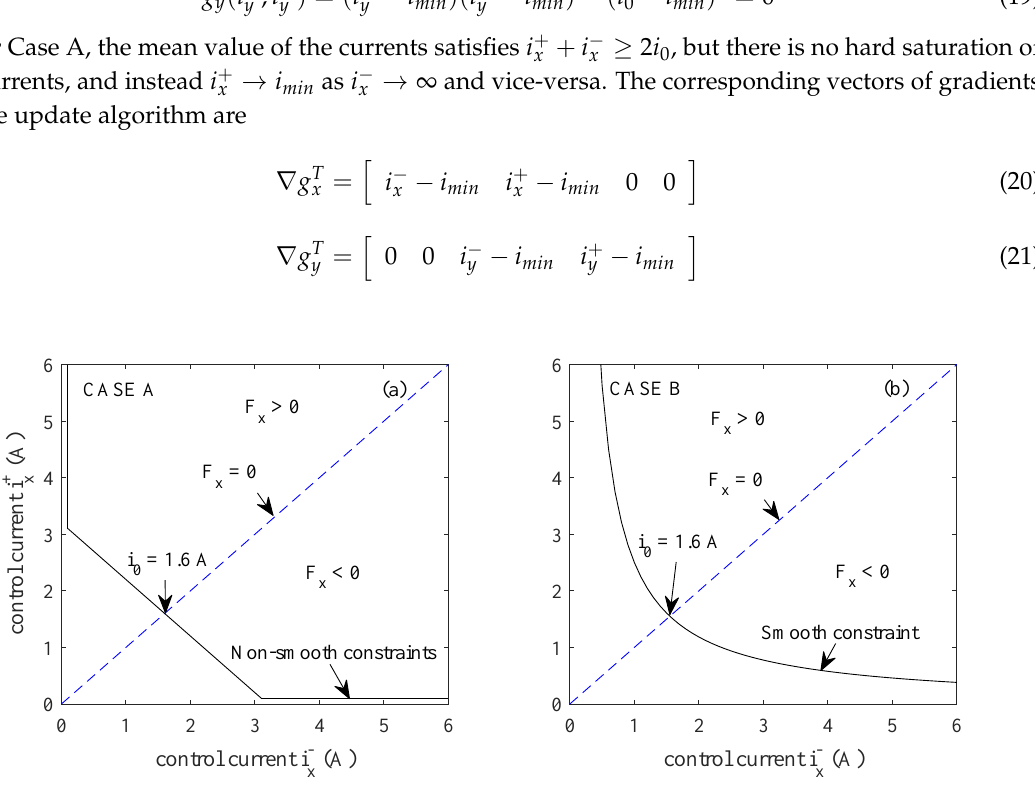
Figure 4. Examples of current constraints g x ( i + x , i − x ) = 0 for use in bearing operation ( a ) non-smooth constraint (Equation (14)) ( b ) smooth hyperbolic constraint (Equation